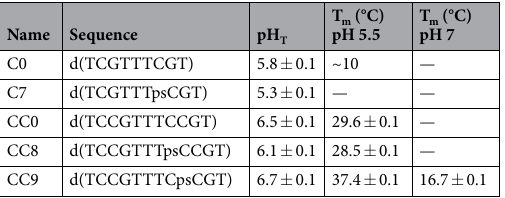
Table 1. Melting temperature and pH T values of C0 , C7 , CC0 , CC8 and CC9 . Experimental conditions: [oligonucleotide] = 20 μ M, 25 mM of buffer solution (cacodylate (pH 5.5) or phosphate (pH 7)) and 100 mM NaCl.